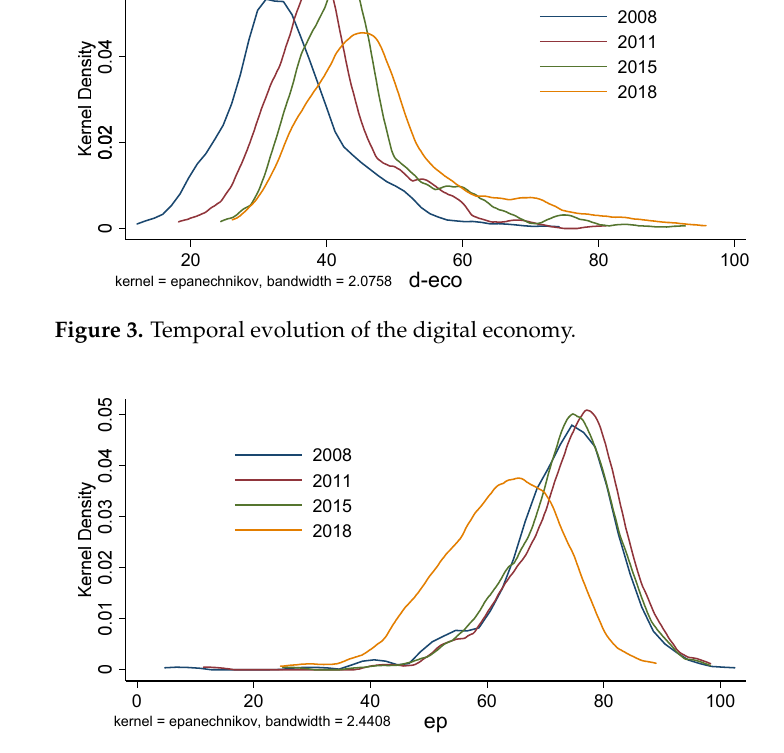
Figure 4. Temporal evolution of environmental pollution.